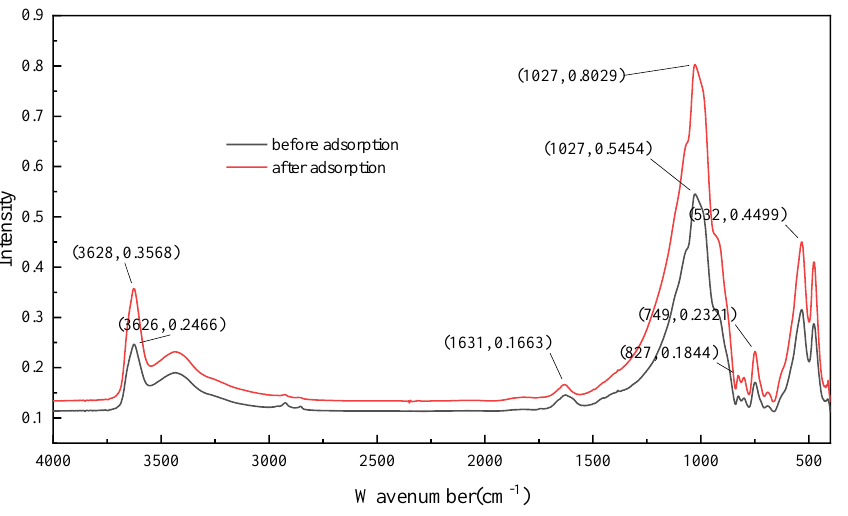
Figure 9. FT-IR spectrum of mica before and after thiourea adsorption.